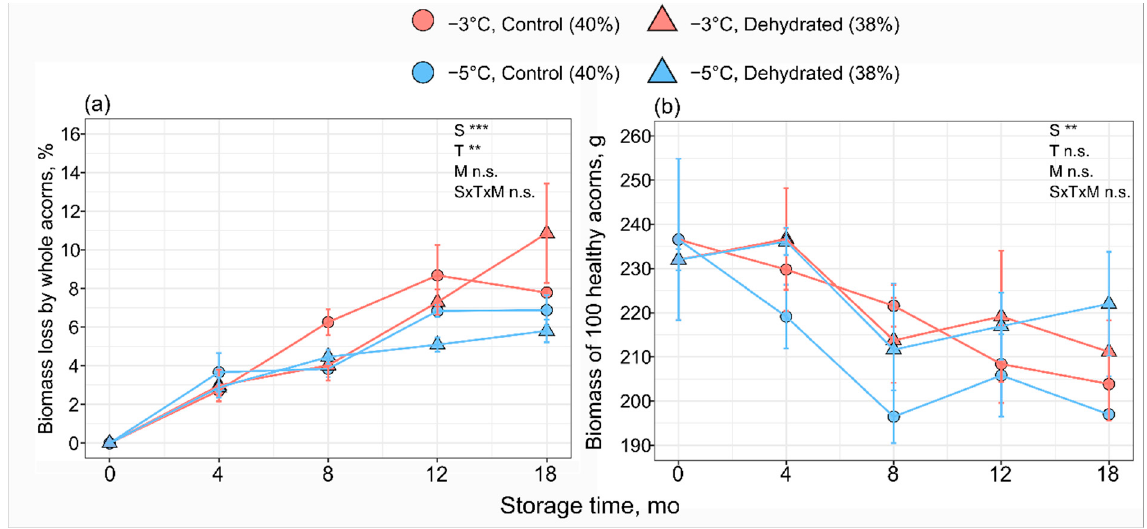
Figure 3. Relative loss of dry biomass of acorn batches with 38% or 40% initial moisture content (M) stored over 18 mo at temperatures (T) of − 3 °C or − 5 °C ( a ) and change of biomass expressed per 100 healthy acorns ( b ). Means (±SE) of three batches are shown. Main effects and a three-way interaction of a factorial ANOVA are given (*** p < 0.001, ** p < 0.01), with S indicating sampling date. For detailed statistical results, please see Table S1.